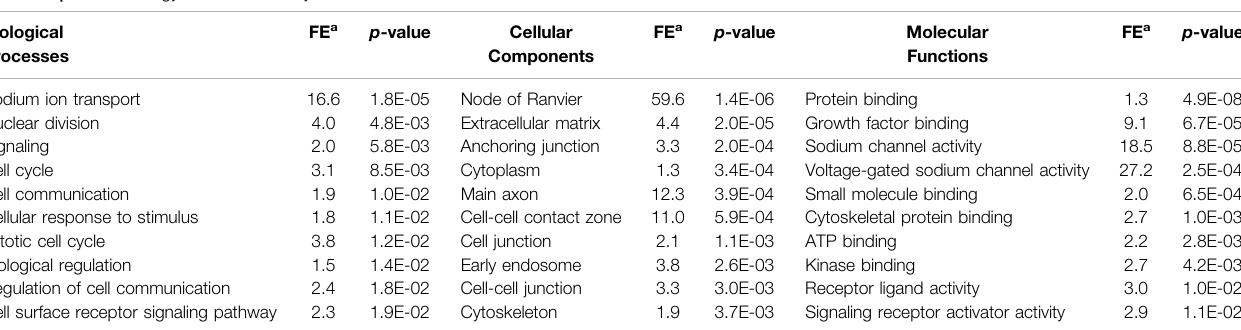
TABLE 1 | Gene ontology enrichment analysis of 15